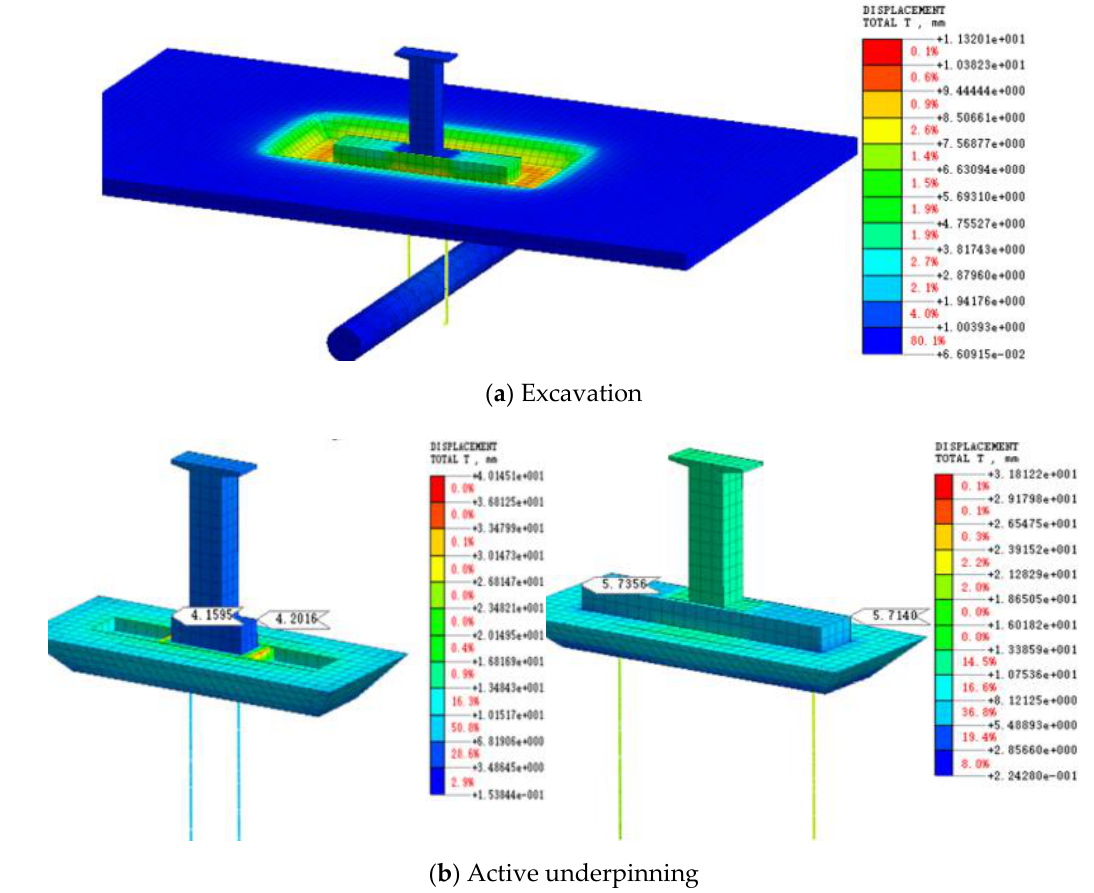
Appl. Sci. 2021 , 11 , x FOR PEER REVIEW Figure 7. Vertical displacement of the numerical model. Figure 7. Vertical displacement of the numerical model.